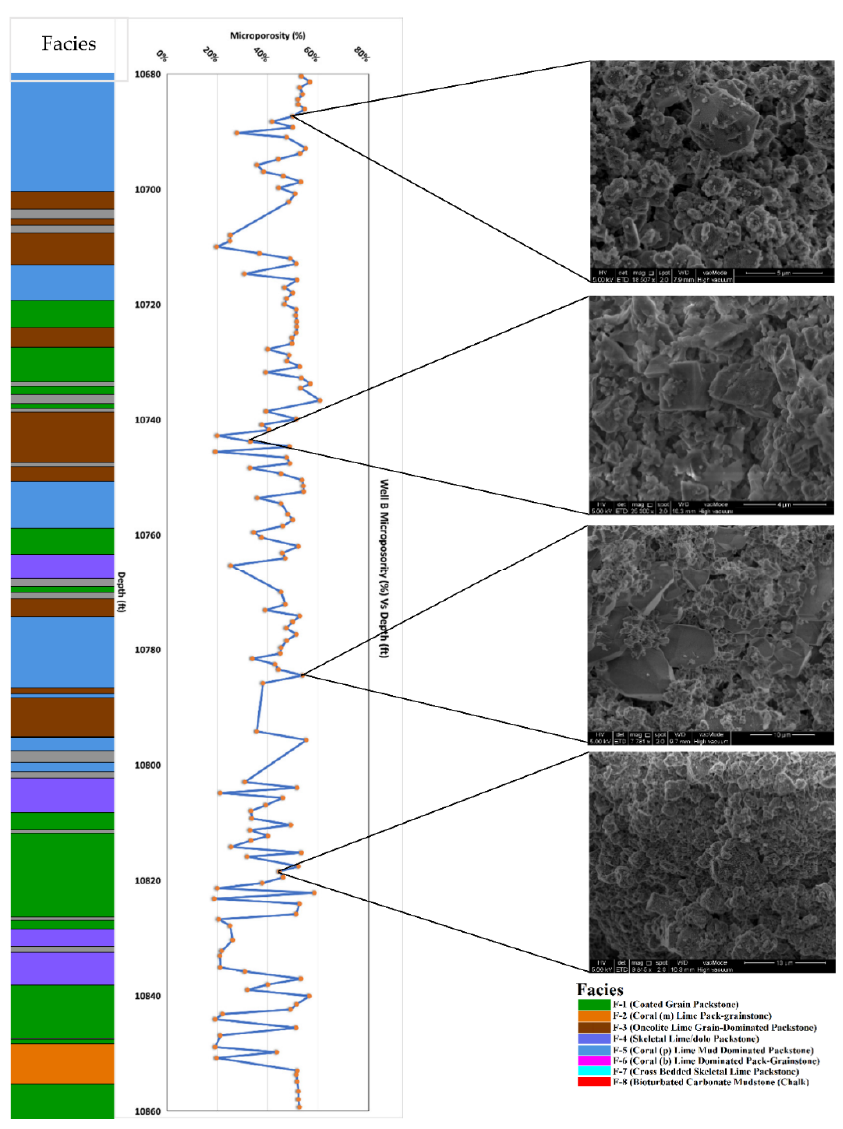
Figure 12. The observation of different microtextures with microporosity occurrence using FESEM at different depth of reservoir interval of Well A, Central Luconia, offshore, Sarawak, Malaysia.